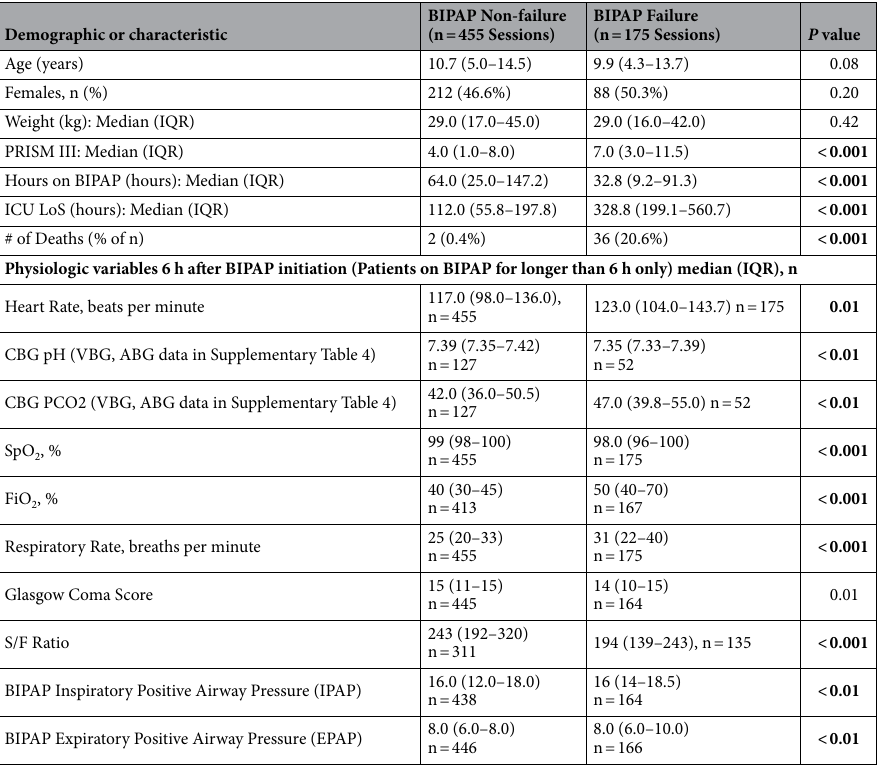
Table 1. Demographics and physiologic variables study participants ( P values from Mann–Whitney U test). Significant values are in bold.